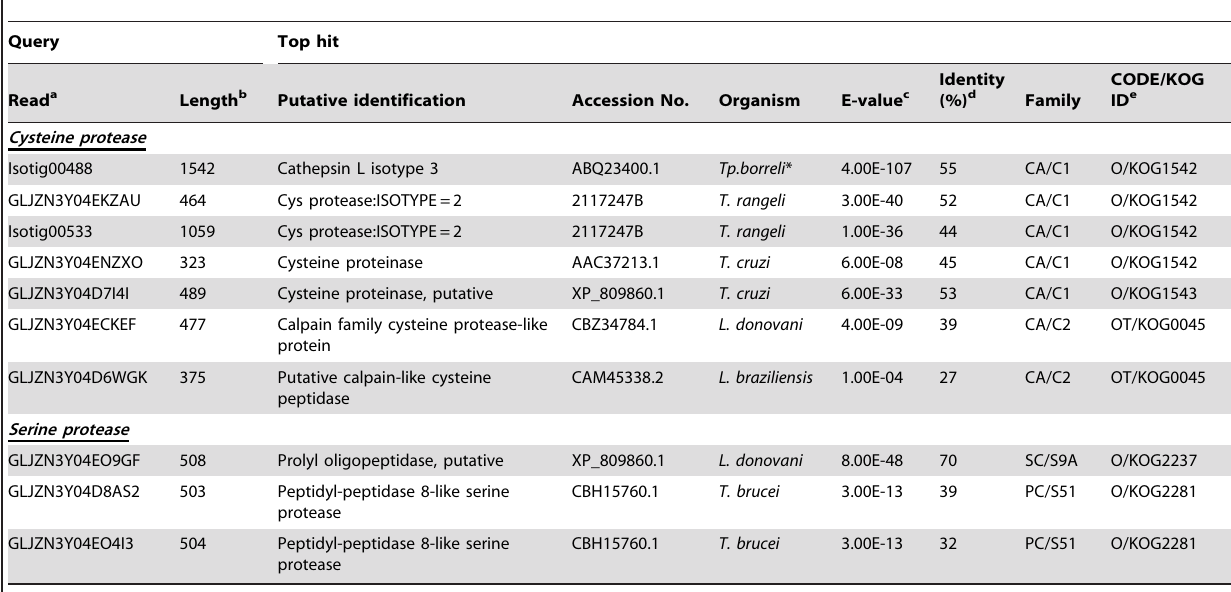
Table 2. Putative transcripts encoding cysteine- or serine proteases of the Kinetoplastida.